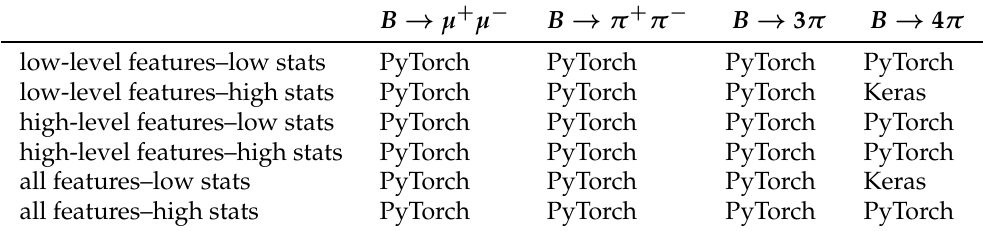
Table 9. Best library for each analysis and each training option for the data.